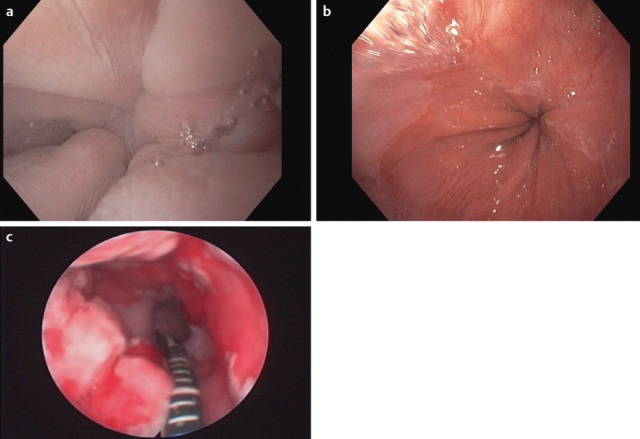
Position 5 – in front of the lower esophageal sphincter; a – clear water is collected in front of the cardia; b – the cardia opens; the esophago-gastric transition becomes visible; c – Barrett’s mucosa in the distal esophagus.